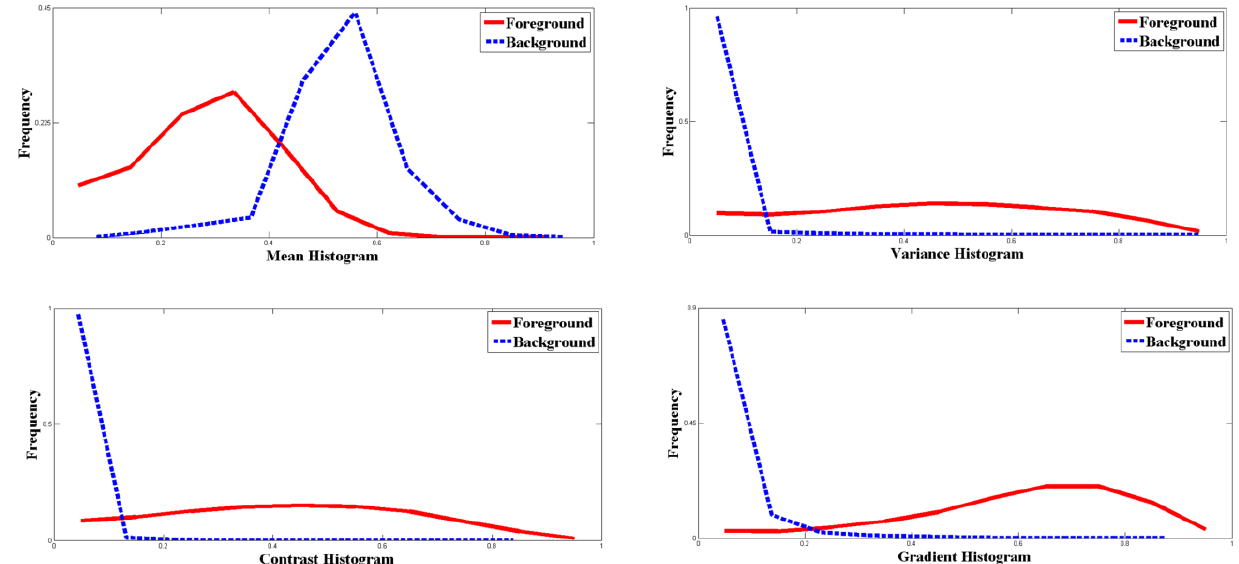
Figure 3. Features’ histograms of fingerprints in 9 different sub-databases of FVC2000, FVC2002 and